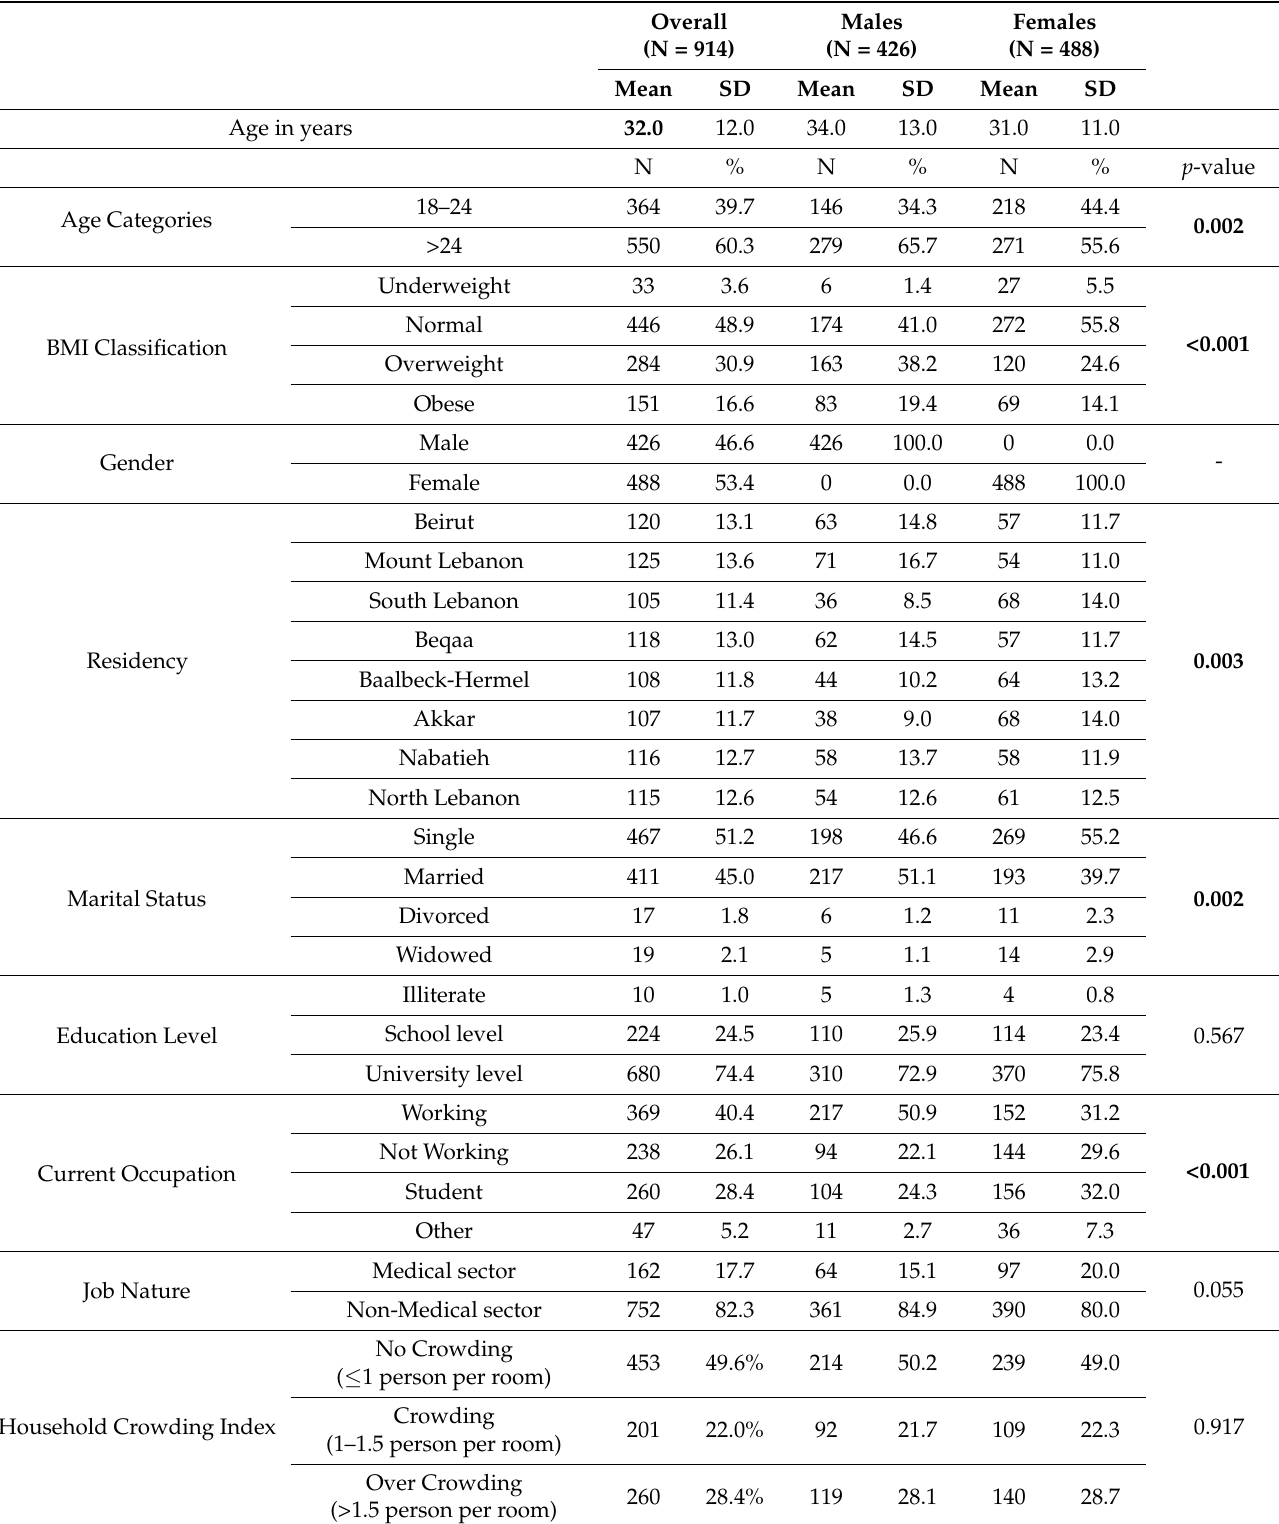
Table 1. Demographic and socio-economic characteristics of the sampled households, overall and by